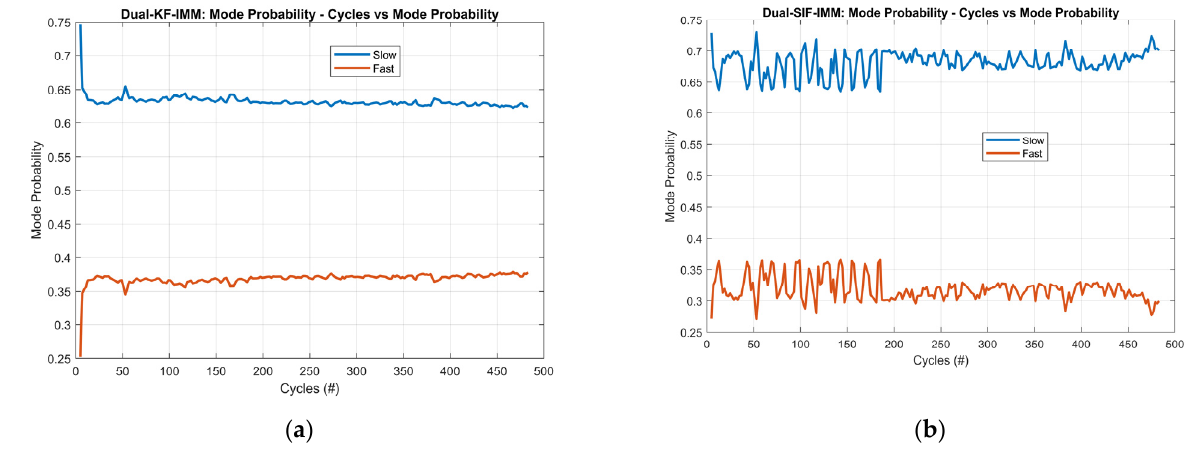
Figure 22. ( a ) Dual-KF-IMM mode probability. ( b ) Dual-SIF-IMM mode probability.